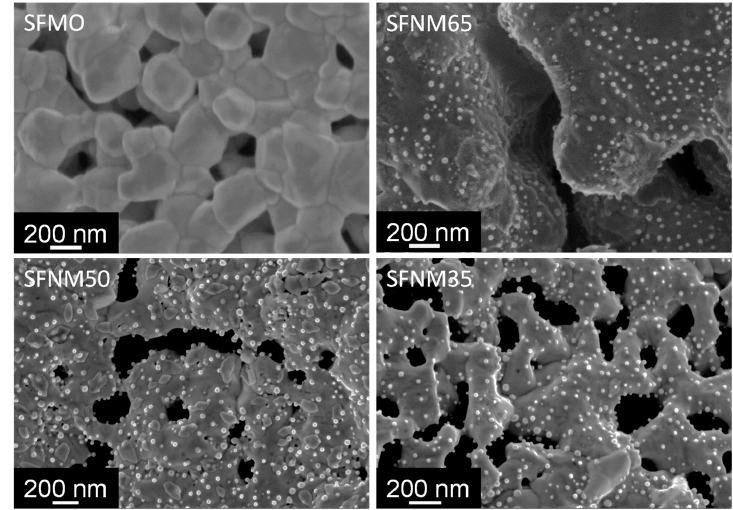
Figure 3. SEM micrographs of the Sr 2 Fe x Ni 1-x MoO 6- δ materials after the exsolution process carried out at 900 °C for 2 h under a 5% H 2 atmosphere.